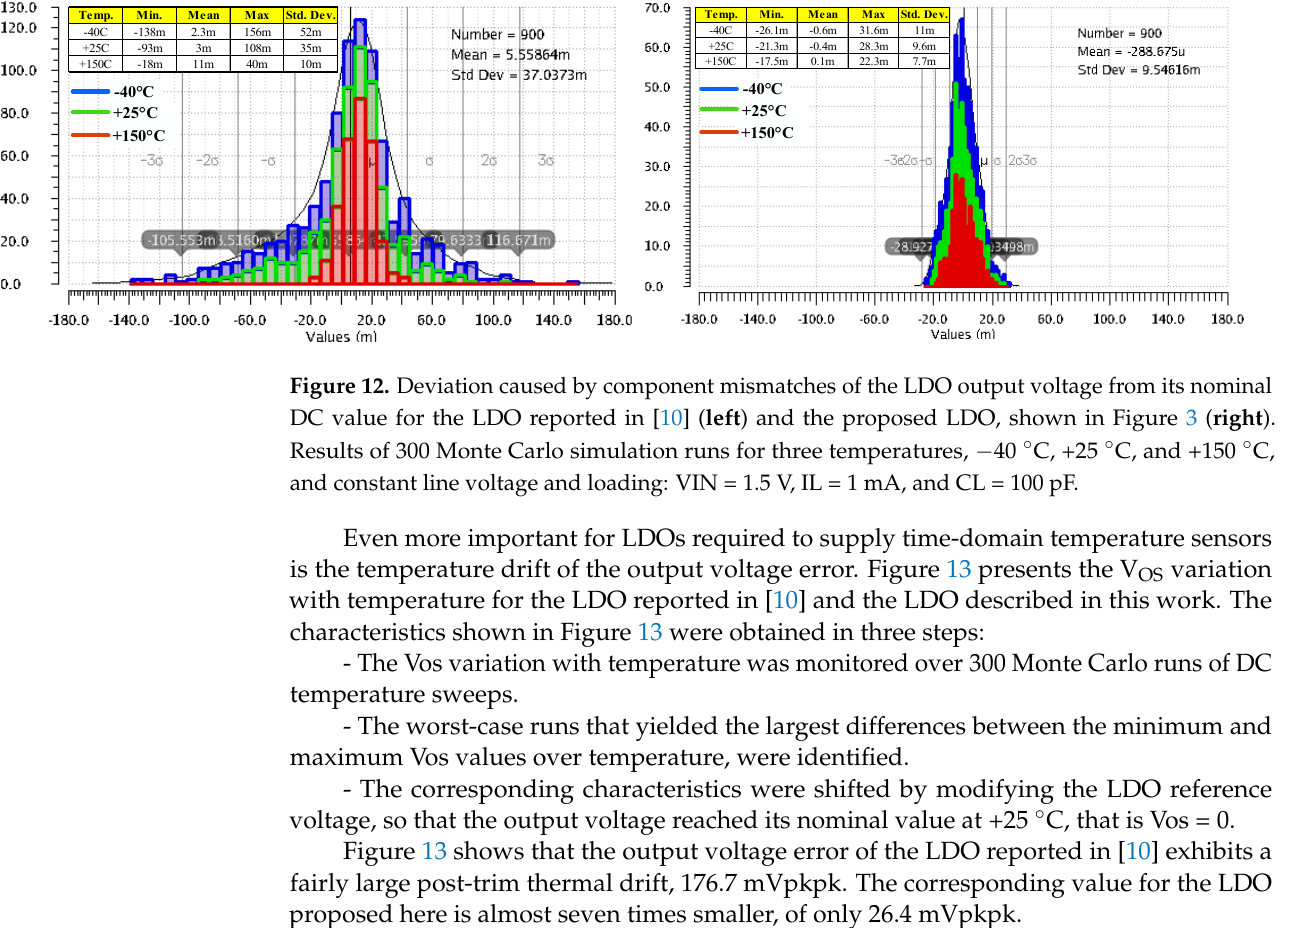
Figure 11. Variation of the LDO output voltage when IL changes its value from 0 A to 100 mA, for the LDO reported in [10] ( left ) and the proposed LDO, shown in Figure 3 ( right ). Results yielded by 300 Monte Carlo simulation runs for three temperatures, − 40 °C, +25 °C, and +150 °C, and constant line voltage, VIN = 1.5 V.